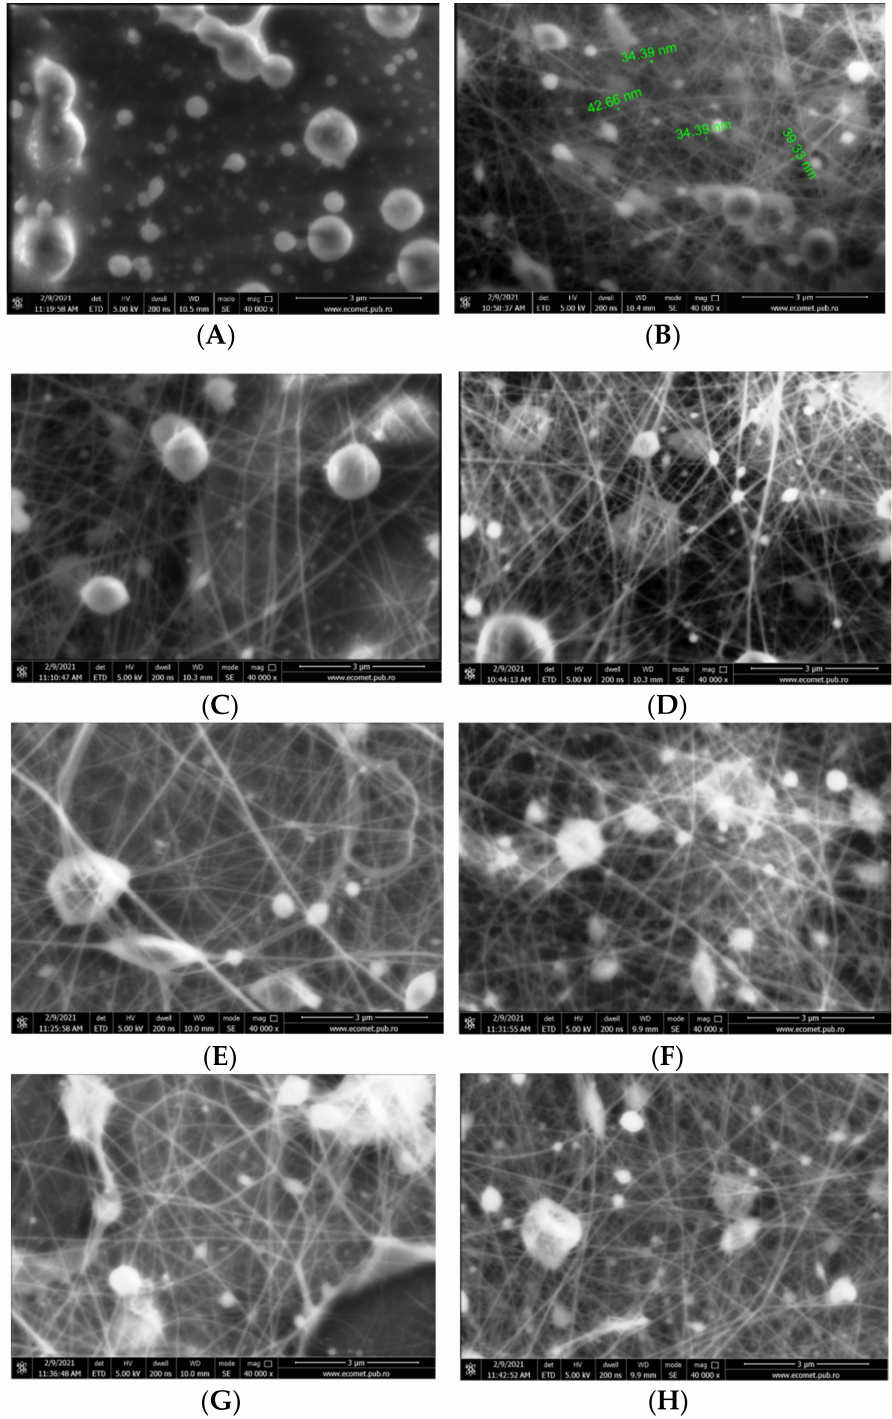
Figure 3. HCB-CS nanofibers ( A ); HCB-CS/Dill EO nanofibers ( B ); HCB-CS/ Lemon balm EO nanofibers ( C ); HCB-CS/Dill EO&Lemon balm EO nanofibers ( D ); HCR-CS nanofibers ( E ); HCR- CS/Dill EO nanofibers ( F ); HCR-CS/Lemon balm EO nanofibers ( G ); HCR-CS/Dill EO&Lemon balm EO nanofibers ( H ). Dill EO showed characteristic peaks at 1045 cm − 1 , 1104 cm − 1 (–C–O–C stretching), 1447 cm − 1 (C=C bending), 2858 cm − 1 (–CH stretching at methylene hydrogen), and 2923 cm − 1 (asymmetric –CH stretching), similar with those reported by Das et al. [55], i.e., 1742 cm − 1 , 1675 cm − 1 (C=O stretching vibrations), 1339 cm − 1 (C–H bending vibrations